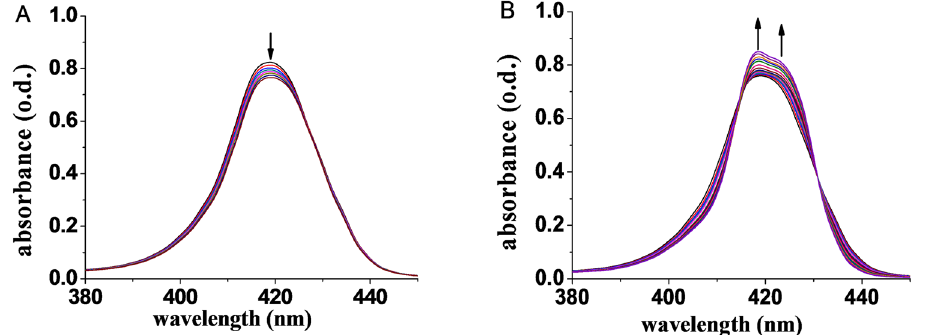
Figure 4. UV-vis spectral change of [Zn 3 -BTATPP] (1.2 × 10 − 6 M) upon addition of 2S as its concentrations change from ( A ) 0–3.1 × 10 − 6 M, ( B ) 7.4 × 10 − 6 –4.2 × 10 − 4